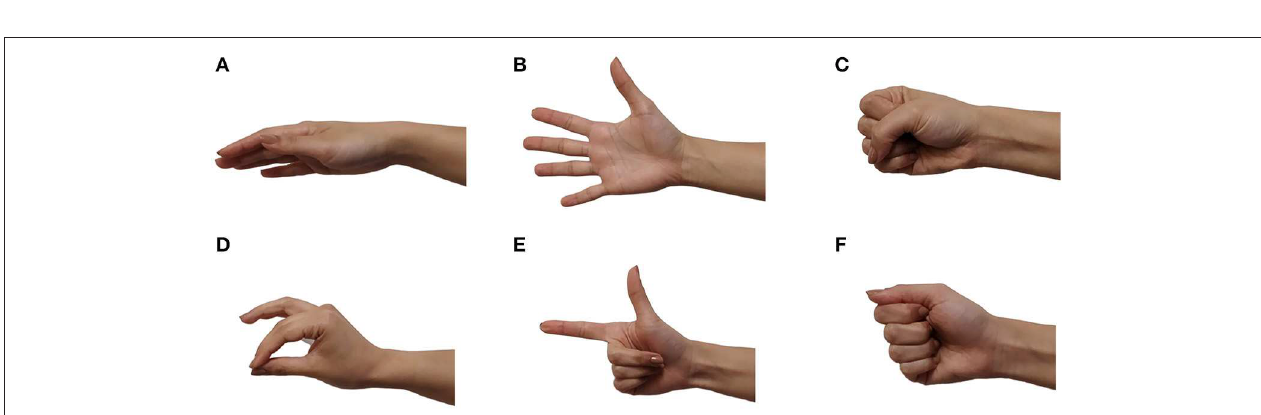
FIGURE 2 | FSR strips placed inside the inner socket representing: (A) the sensor configuration for dataset1, (B) the sensor configuration used for dataset2, and (C) the sensor configuration used for dataset3.